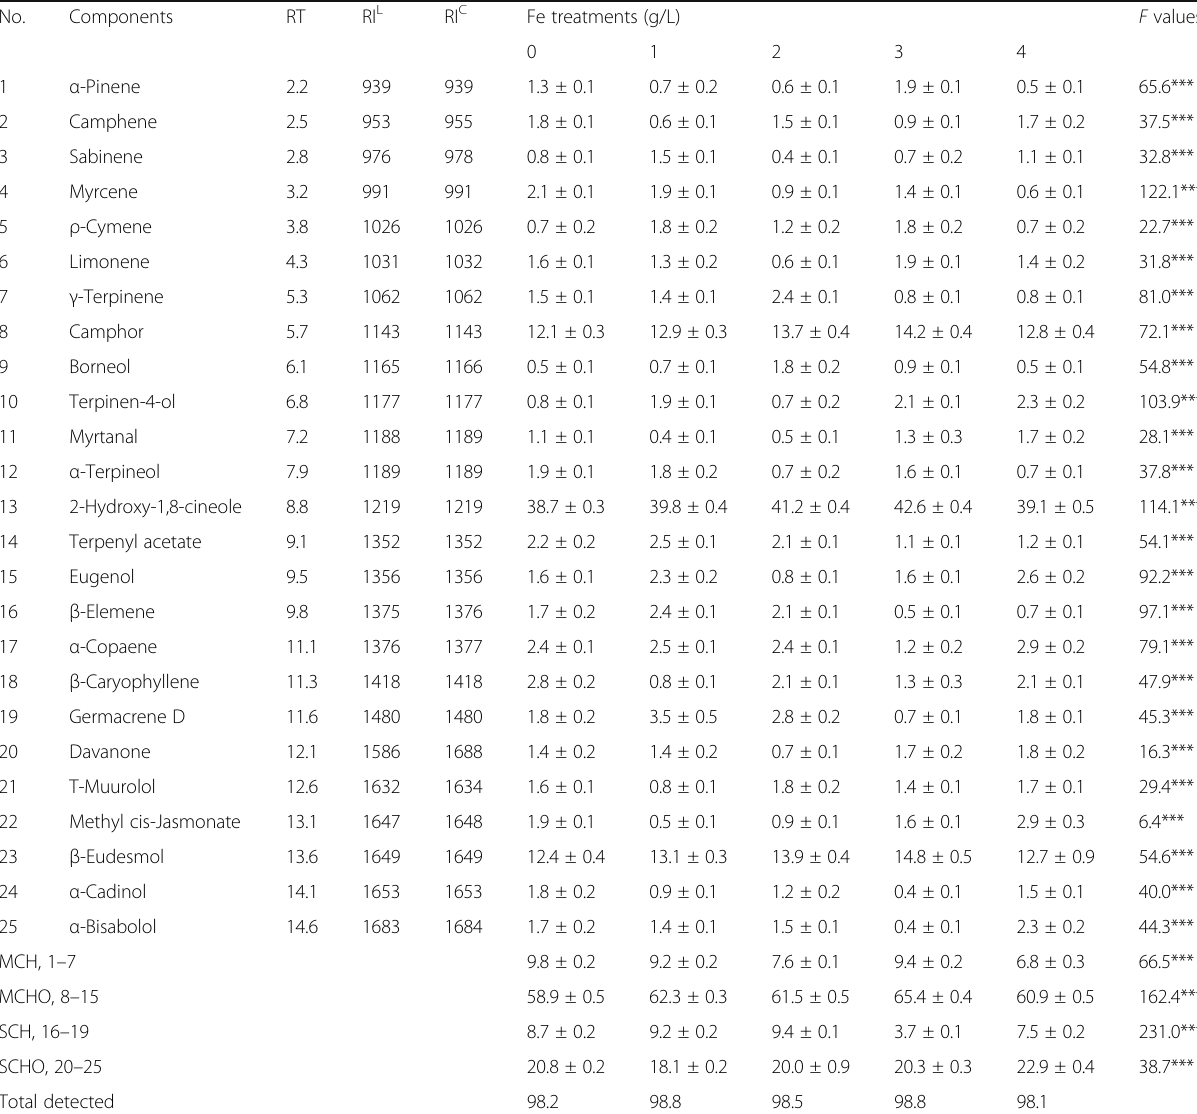
Table 2 Effect of Fe treatments on EO constituents